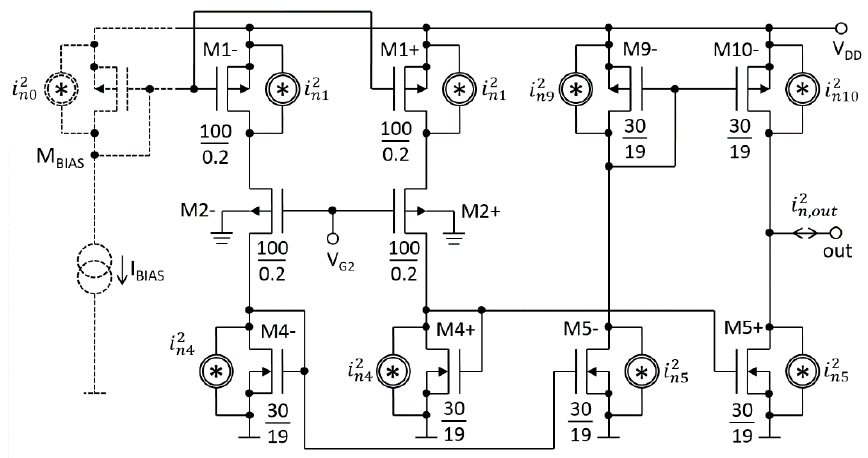
Figure 9. The simplified electrical diagram of the LTA for the noise calculation.